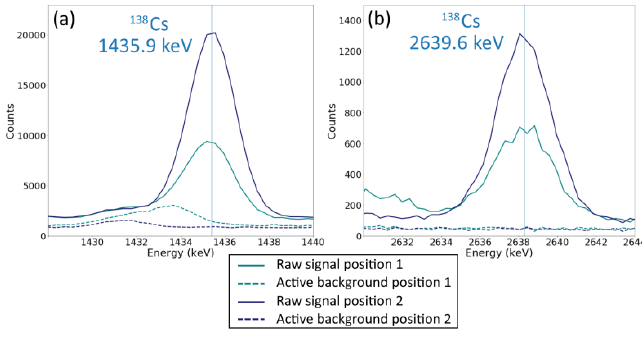
Fig. 5. 1435.9 keV and 2639.6 keV peaks of 138 Cs for the DU sample in the concrete matrix and in the two counting positions (and active